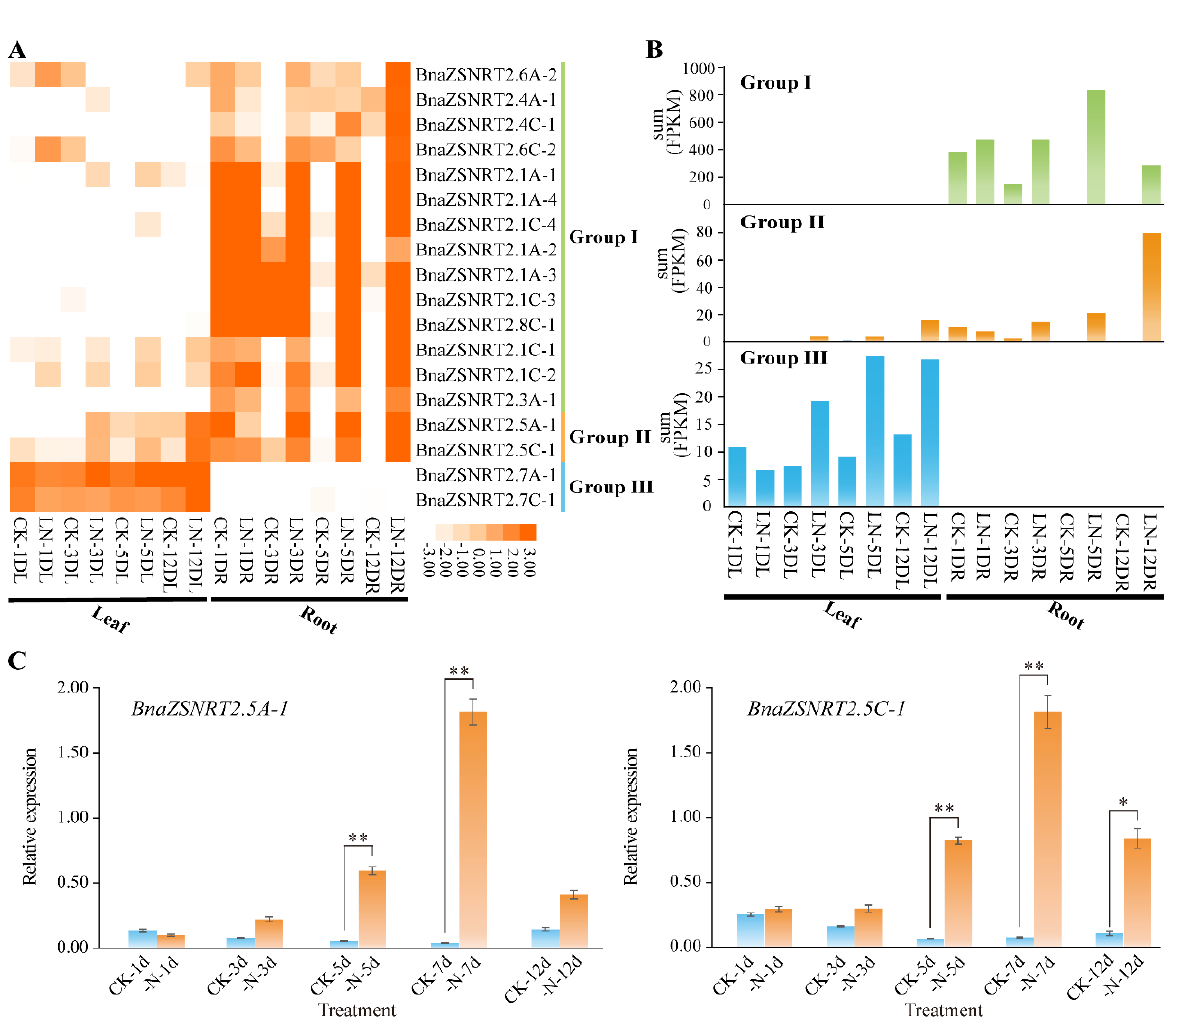
Figure 6. Expression pattern of BnaZSNRT2s under low nitrogen (LN) stress treatments. ( A ) The expression profiles of BnaZSNRT2s in ‘ZS11’ seedling leaf and root tissues under LN stress treatment based on RNA-Seq dataset. “CK” = normal N condition, “LN” = Low N; “D”, “L”, and “R” indicate day, leaf, and root, respectively. ( B ) The sum of expression levels in each group. The ordinate represents the sum of expression levels (FPKM) corresponding to each tissue investigated. ( C ) Expression levels of BnaZSNRT2.5A-1 and BnaZSNRT2.5C-1 under LN treatments by RT-qPCR method. The reference genes were BnaActin7 (GenBank accession no. AF024716) and BnaUBI (GenBank accession no. NC027770). Error bars represent the standard deviation of three independent experiments. *: Significant difference (0.05 > p > 0.01); **: Extremely significant difference.